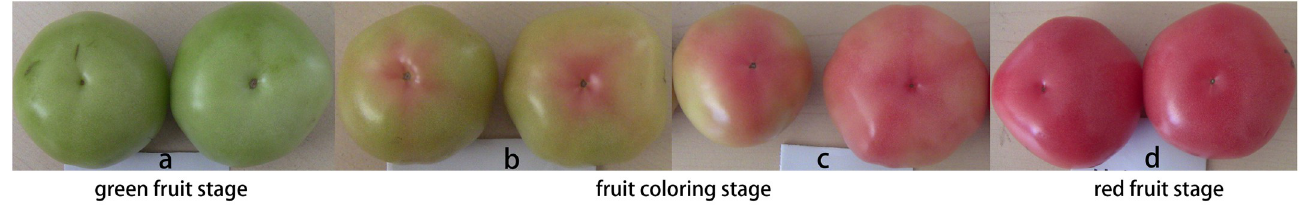
Fig 6. Color change and maturity of tomato fruits.